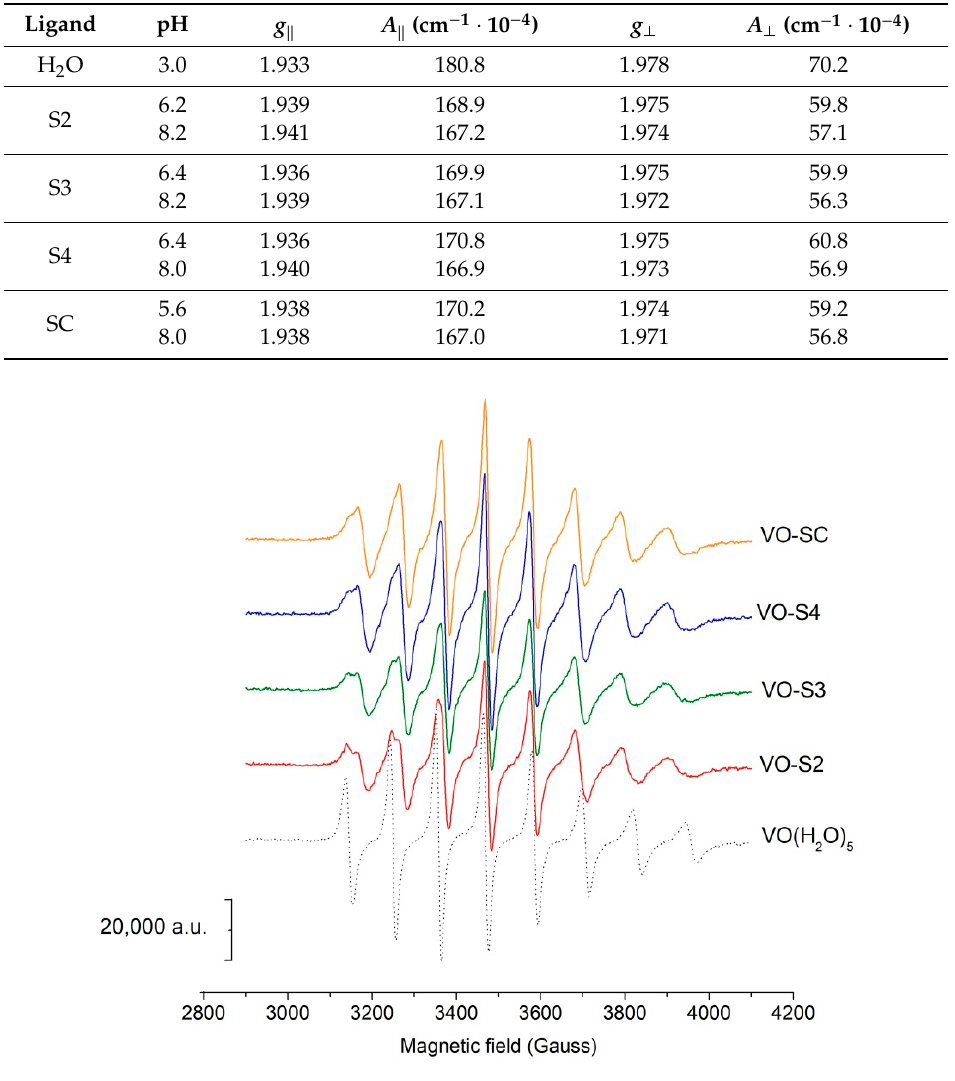
Figure 5. RT EPR spectra in acidic conditions. EPR spectra of solutions with oxovanadium(IV) 5 mmol L − 1 and different ligands 15 mmol L − 1 at pH 2.5.